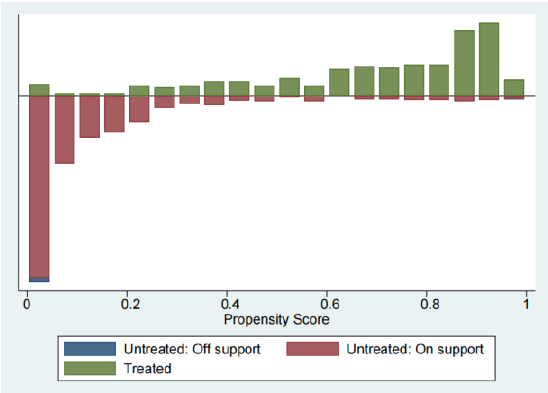
Figure 5. Equality test of the means of variables before and after matching.